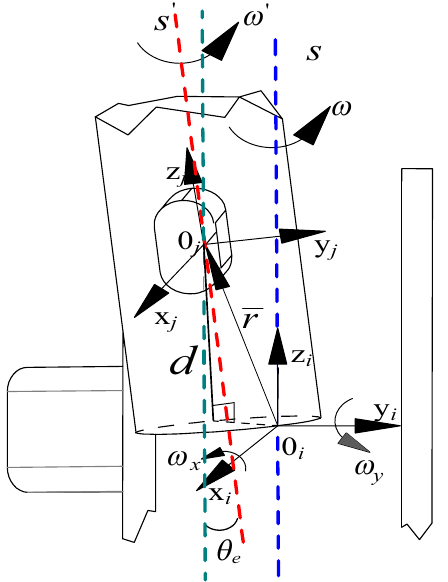
Figure 10. Schematic diagram of the error screw of axial movement and spatial